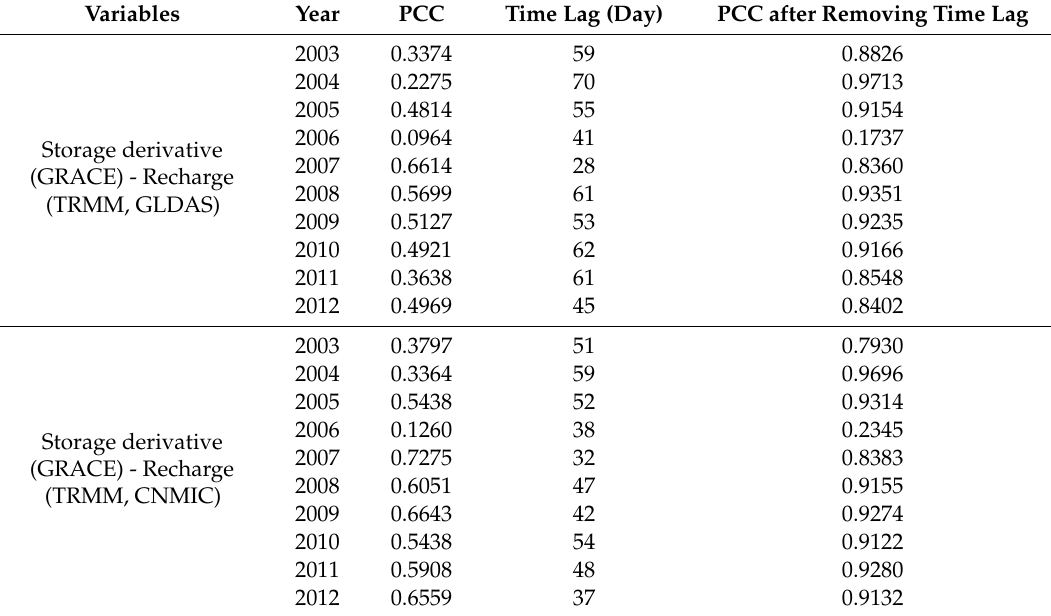
Table 1. The correlation coe ffi cients of each year’s storage and recharge (two versions), and time lags that maximize the correlation coe ffi cients. The time lag in this table refers to the days that storage change signals fall behind the recharge